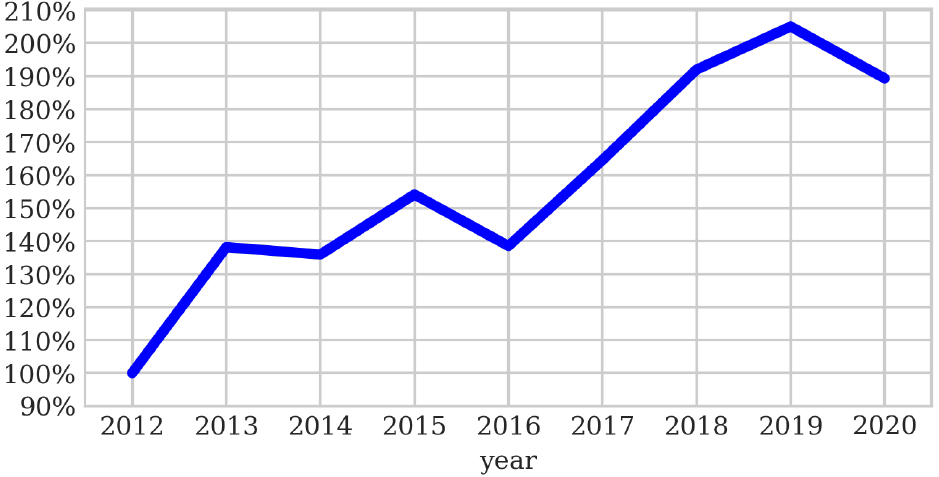
Figure 12. Locomotive productivity of DB Cargo Polska in tkm per locomotive, normalized to 2012. Own study based on company